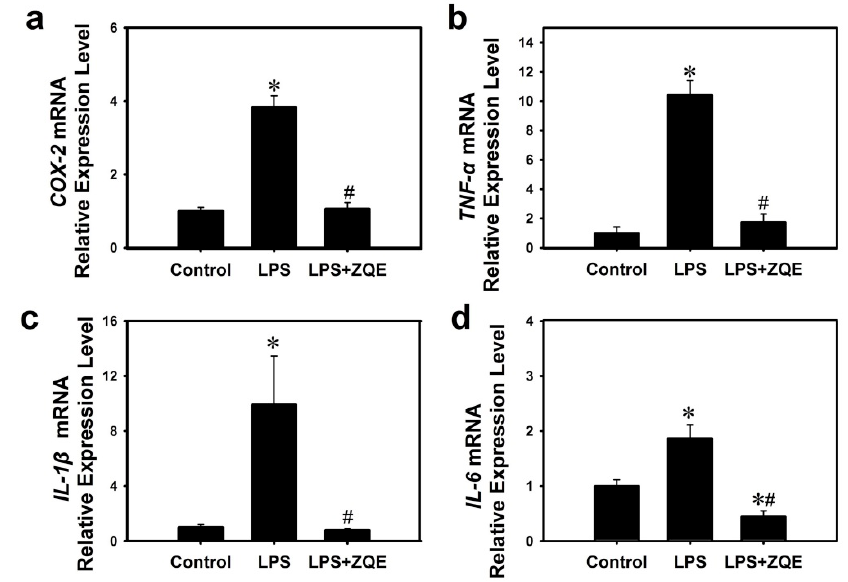
Figure 6. Effects of ZQE on LPS-induced mRNA expression of COX-2, TNF- α , IL-1 β , and IL-6 ( a – d ) in primary BMDCs. The concentrations of LPS and ZQE is 100 ng/mL and 1 μ g/mL, respectively. The data shown are from three independent experiments and expressed as mean ± SD. * p < 0.05 and # p < 0.05 compared the control (with no LPS or ZQE) and LPS alone, respectively. LPS: lipopolysaccharide;